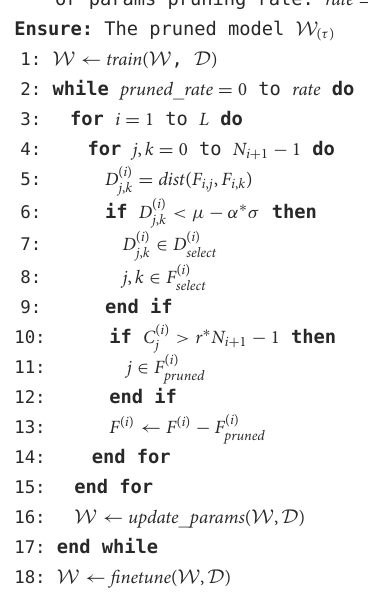
Algorithm 1. Iterative pruning